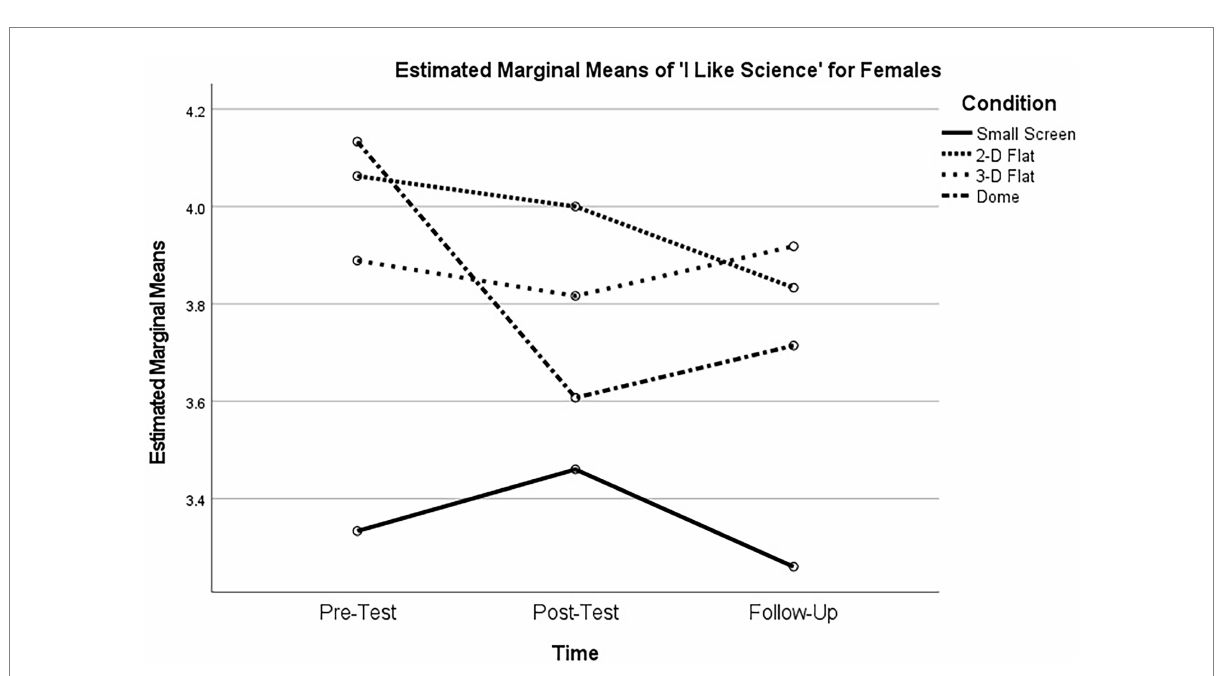
FIGURE 6 “I like science” performance for the females only.